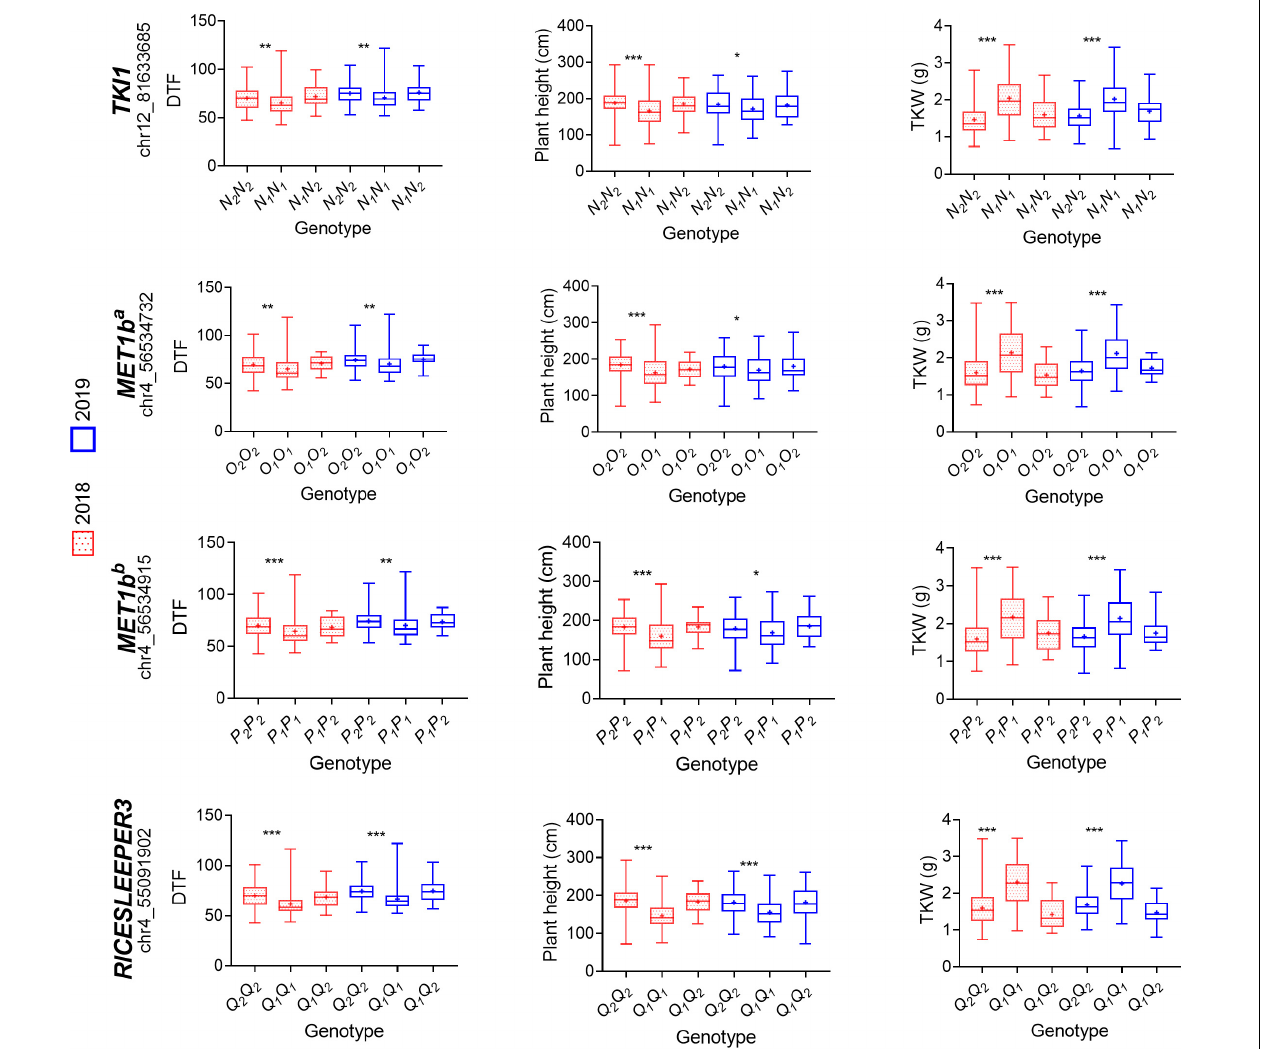
FIGURE 7 | Evaluation of variant haplotypes using available whole-genome sequencing and phenotypic data of 310 quinoa accessions. Phenotypic effects of four haplotype variations within three candidate genes are shown: TSL-KINASE INTERACTING PROTEIN 1 ( TKI1 ) (SNP: chr12_81633685), DNA (CYTOSINE-5)-METHYLTRANSFERASE 1 ( MET1b a ) (frameshift variant chr4_56534732), MET1b b (disruptive inframe deletion chr4_56534915), and RICESLEEPER3 (disruptive_inframe_insertion chr4_55091902). The variants genotypes correspond to, for instance, N 1 N 1 (our homozygous parent PI-614889), N 1 N 2 (heterozygous), N 2 N 2 (our homozygous parent CHEN-109) and are described in Supplementary Table 4 . Significant differences between genotypes are shown by asterisks ( t -test, α < 0.05 = ***, α < 0.01 = **, α < 0.001 = *). Phenotypic data of different years are shown in different colors. DTF: days to flowering, TKW: thousand kernel